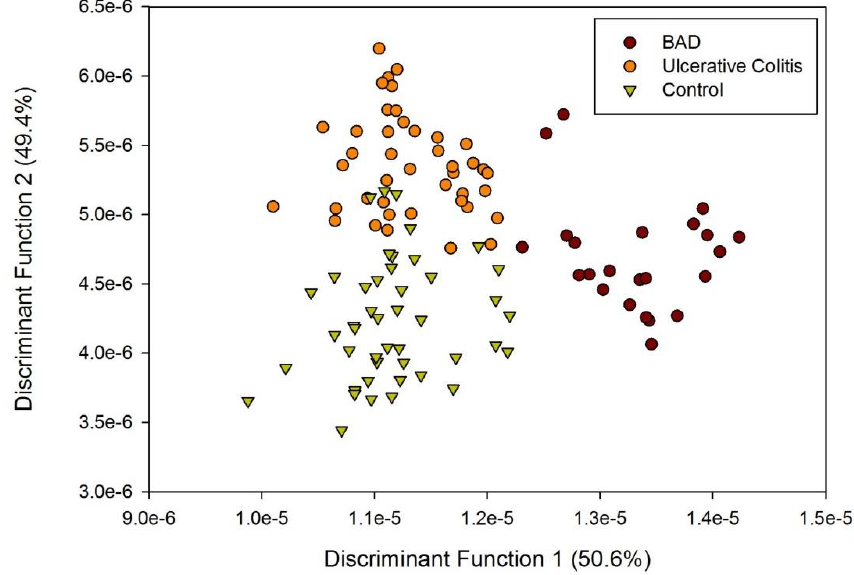
Figure 4. Linear Discriminant Analysis of FAIMS